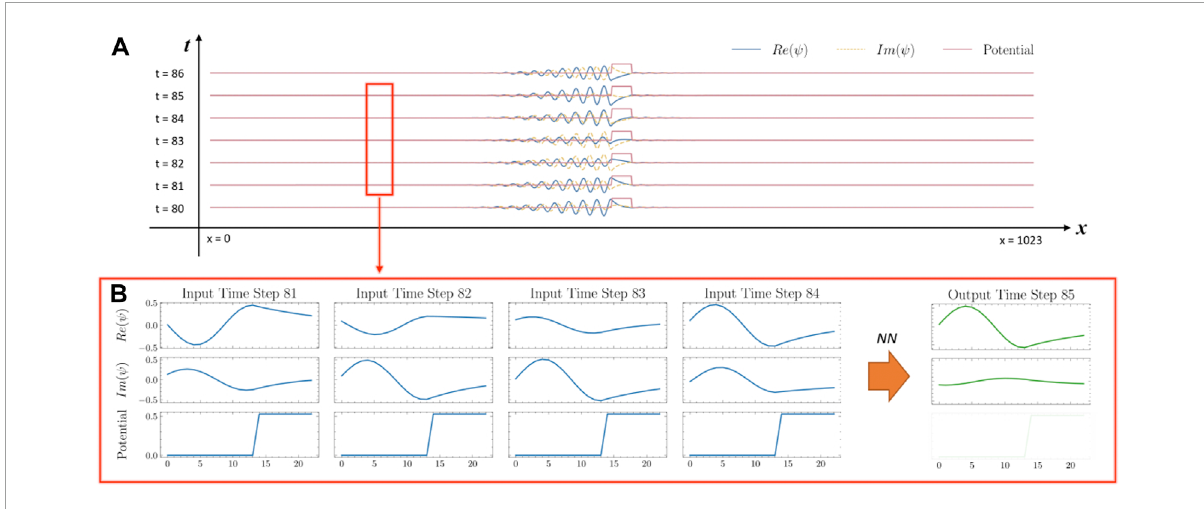
FIGURE 1 Structure of the input. (A) , The input data consists of a time series of one-dimensional plots, i.e., the real and the imaginary parts of the wave function, as well as the values of the potential barrier. (B) , All input information can be represented as a tensor, with three channels (similar to RGB channels when representing visual